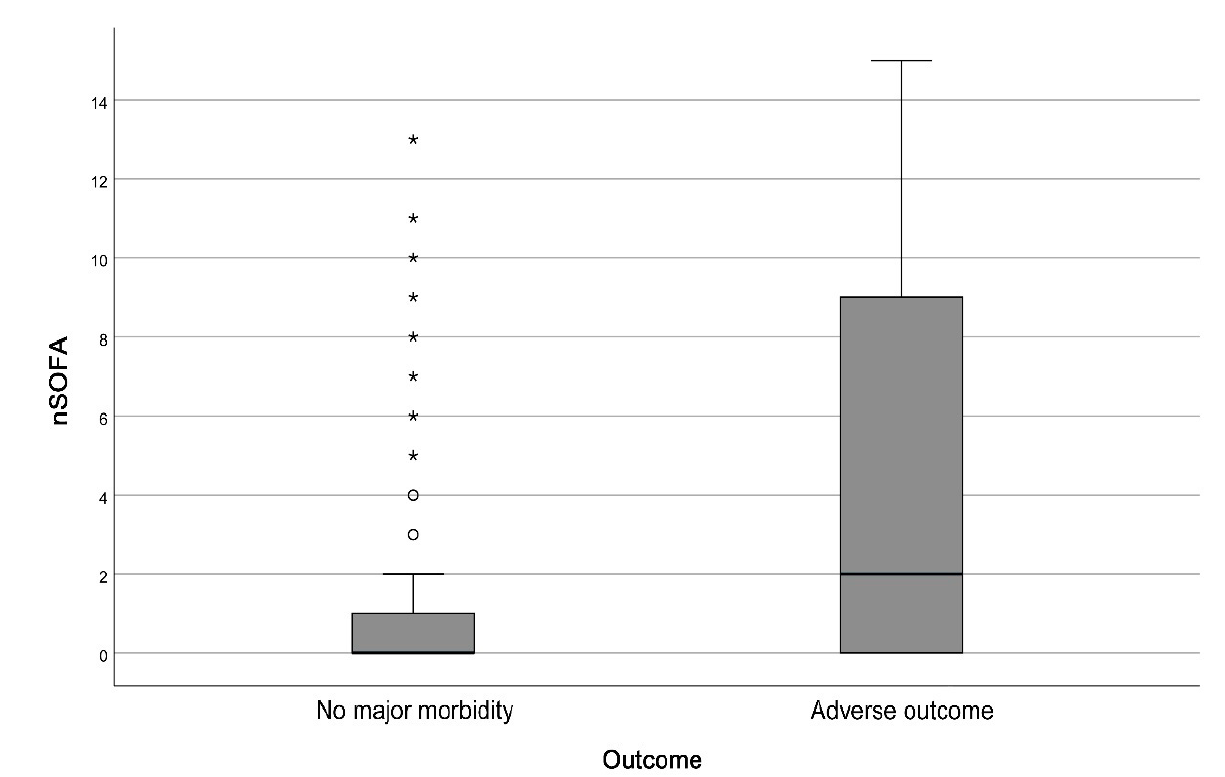
Figure 2. Comparison of nSOFA peak values in the first 72 h after birth between the group with no major morbidity (median 0, IQR 0–1) and with adverse outcome (median 2, IQR 0–9). Mann-Whitney U test, p -value < 0.001. Circles represent outliers, stars represent far out values according to Tukey’s fences. nSOFA = Neonatal Sequential Organ Failure Assessment. Adverse outcome = Death or major morbidity.